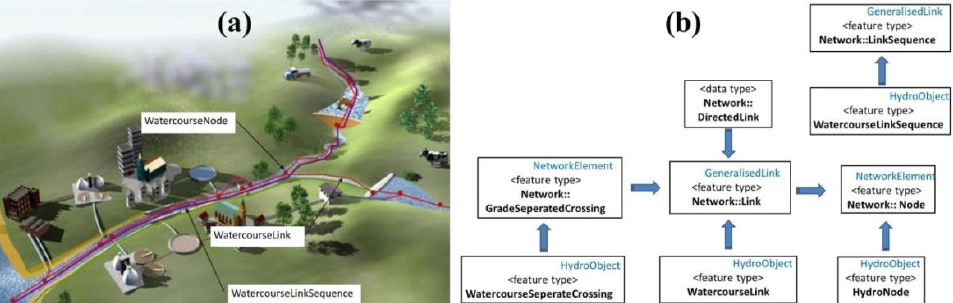
Figure 4. ( a ) Physical representation of elements; ( b ) database and relations for the hydro network model (adapted from [9]).